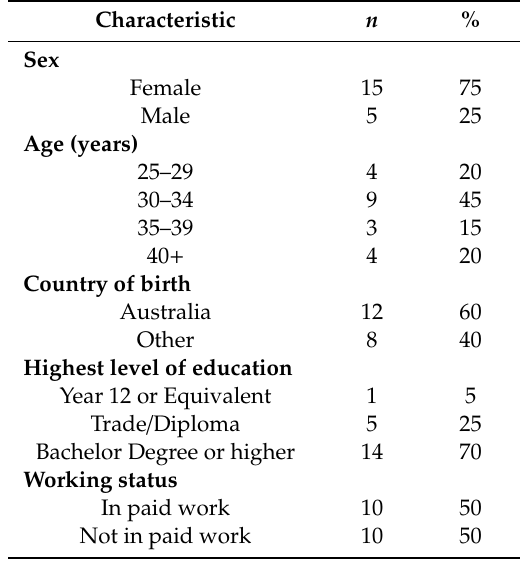
Table 4. Demographic characteristics of interview participants ( n =